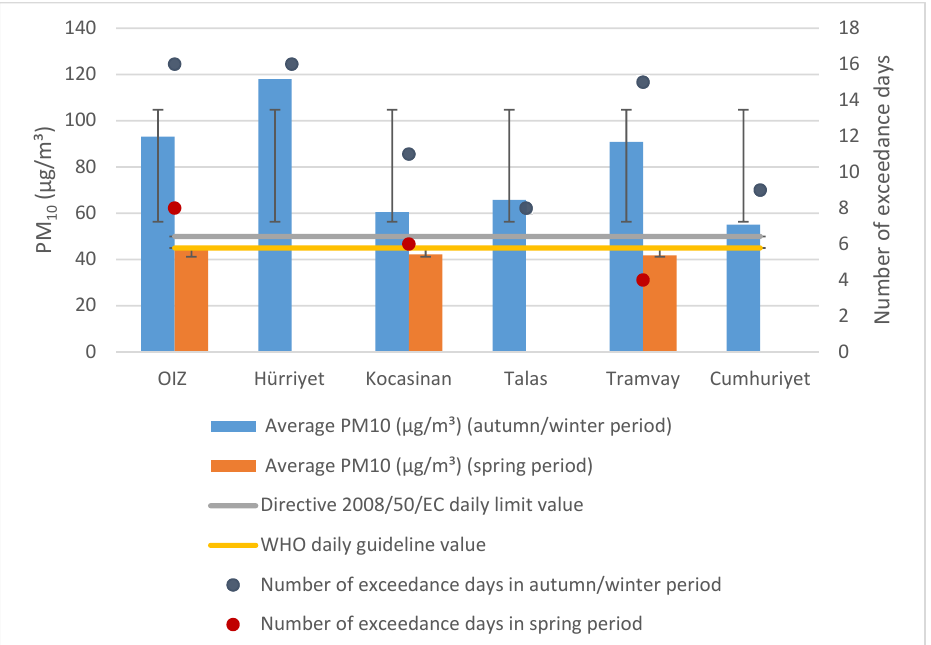
Figure 3. Comparison of daily average PM 10 concentrations with the EU Directive daily limit value, the WHO daily guideline value for PM 10 , and the number of exceedance days. The daily PM 10 concentrations and inversion intensity values, for the autumn/winter and spring periods, are presented in Figures 4 and 5, respectively.